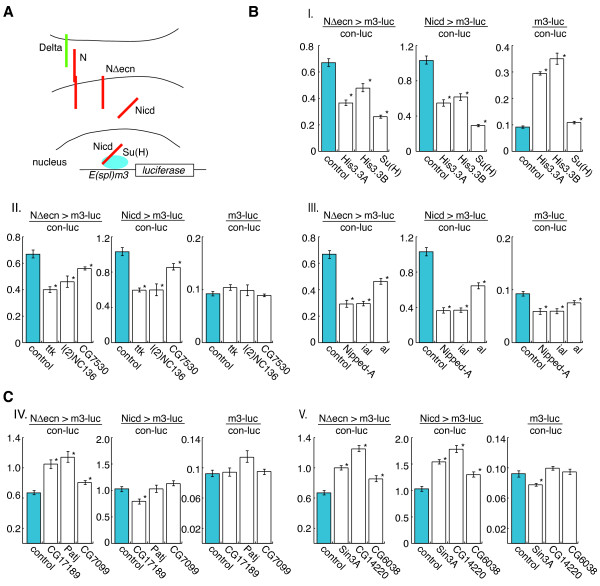
Modulation of Notch transcription for subset of retested genes. A. The two constitutively active Notch constructs used to determine epistatic relationships in the pathway, NΔecn and Nicd. NΔecn is a truncated form of N missing the extracellular domain that is initially membrane bound. NΔecn undergoes constitutive cleavage to form the soluble Nicd that is transported to the nucleus to activate transcription. Su(H) is the canonical Notch pathway transcription factor that represses transcription in the absence of Nicd and is essential for the Nicd activated transcription of targets such as E(spl)m3. B. Transcriptional response to RNAi treatment of selected retested genes that promote Notch signaling. The E(spl)m3 reporter was induced with either NΔecn or Nicd or left in the uninduced repressed state. All three classes down regulate both soluble (Nicd) and membrane bound (NΔecn) Notch-induced signal, yet have different effects on the E(spl)m3 promoter in the absence of active Notch. Class I genes have positive, Class II neutral and Class III negative effect on the repressed signal. C. Transcriptional response to RNAi treatment of selected retested genes that repress Notch signaling. Two classes of hits are noted. Class IV is only effective on the membrane bound form of Notch (NΔecn), while class V is effective on both membrane bound and soluble forms (Nicd). Error bars represent the standard error of the mean (SEM). *Significant deviation from control RNAi treatment, calculated by two-tailed t-test with a p-value < 0.05 (Additional file 5 for full statistics).